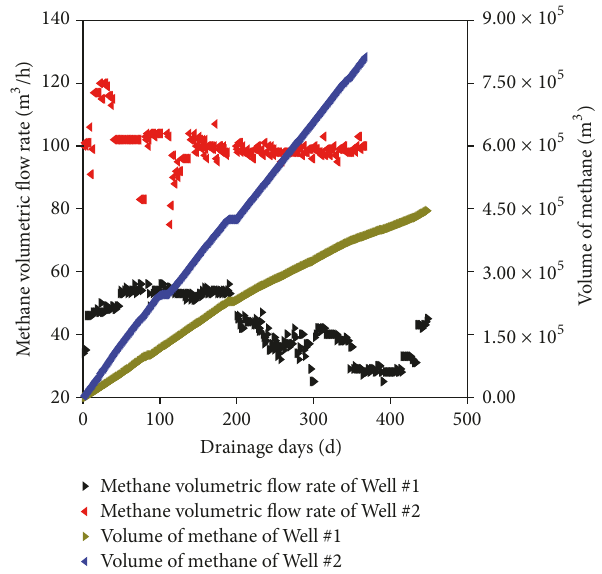
Figure 8: Comparison of methane extraction flow for different well